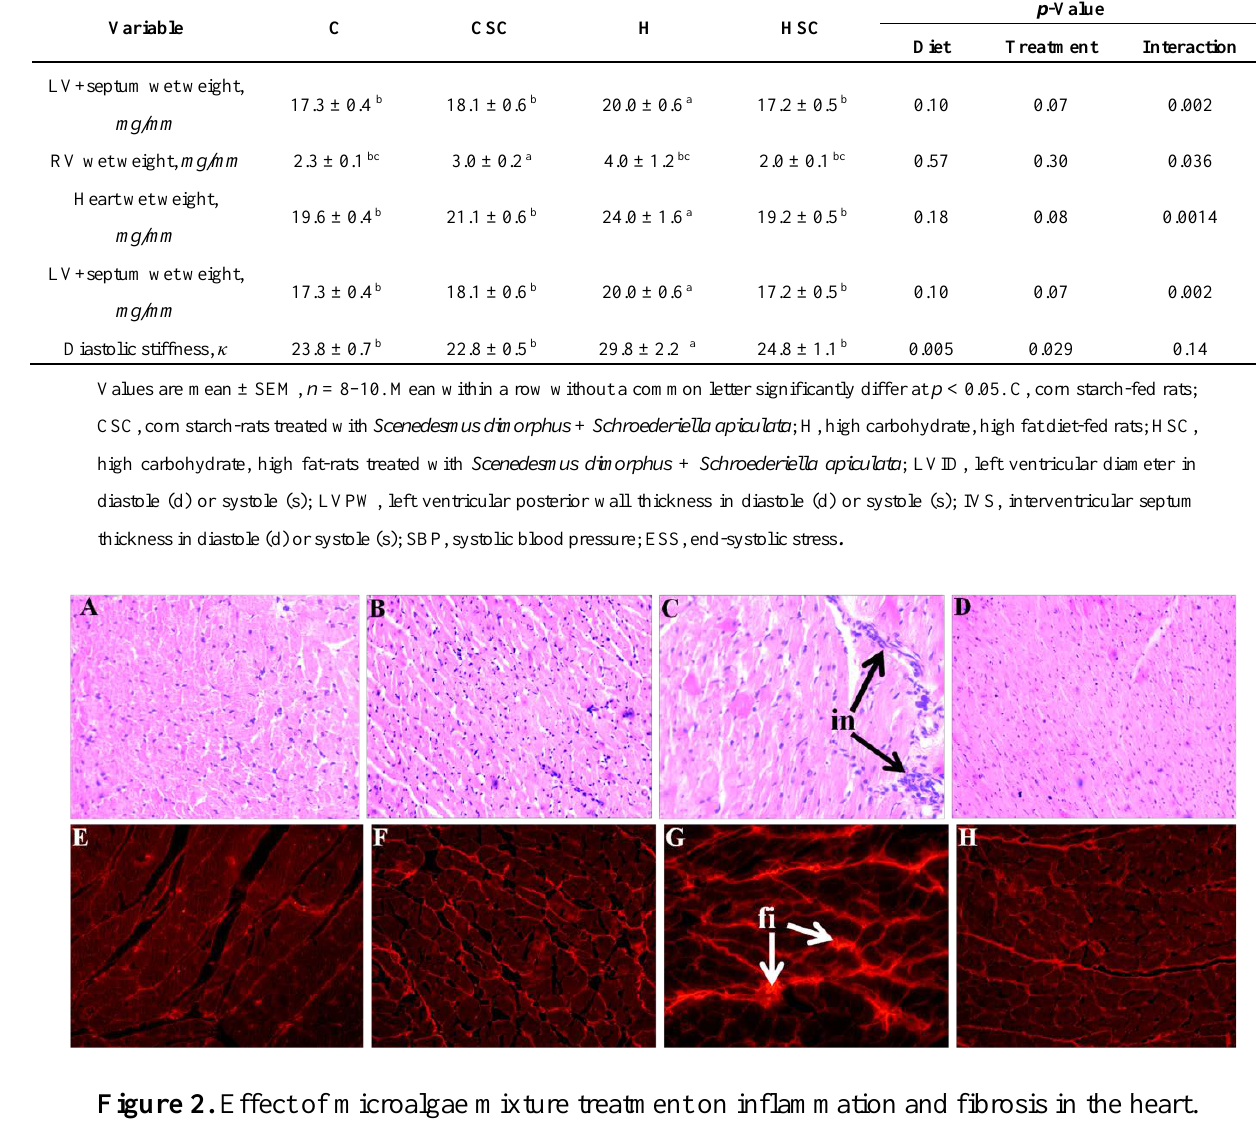
Figure 2. Effect of microalgae mixture treatment on inflammation and fibrosis in the heart. Haematoxylin and eosin staining of left ventricle showing infiltration of inflammatory cells ( A – D , inflammatory cells marked as “in”) (20×) from C ( A ), CSC ( B ), H ( C ), and HSC ( D ). Picrosirius red staining of left ventricle showing collagen deposition ( E – H ), fibrosis marked as “fi”) (20×) from C ( E ), CSC ( F ), H ( G ), and HSC ( H ) rats. C, corn starch fed rats; CSC, cornstarch rats treated with Scenedesmus dimorphus + Schroederiella apiculata ; H, high carbohydrate, high fat diet fed rats; HSC, high carbohydrate, high fat rats treated with Scenedesmus dimorphus + Schroederiella apiculata